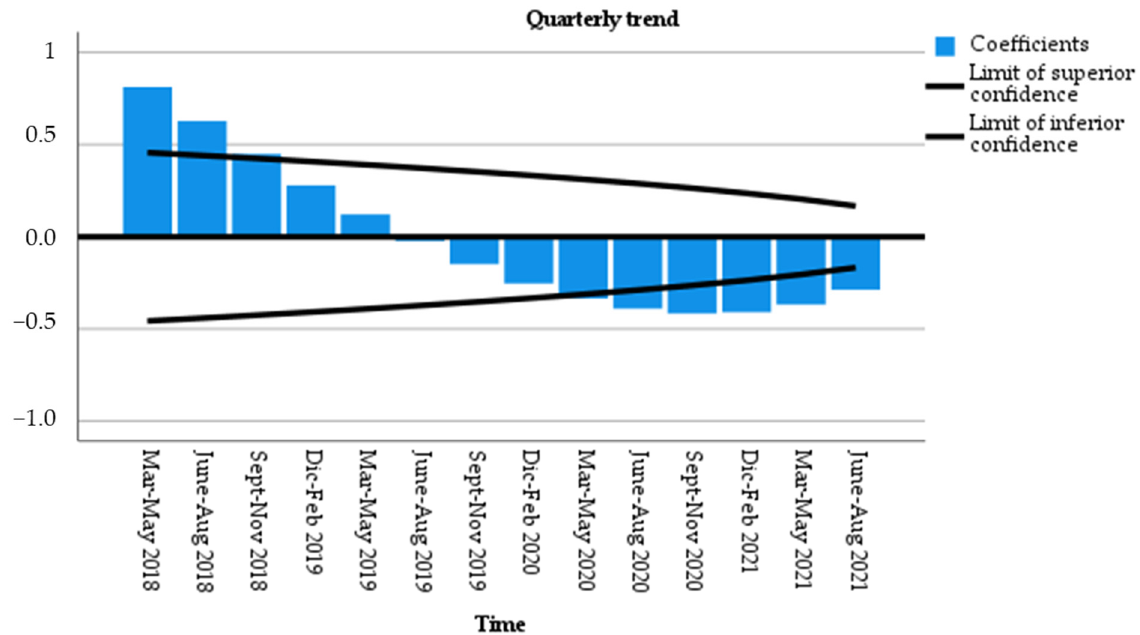
Figure 2. Monthly diagnosis rates and relative moving average (order 3) between March 2018 and February 2022.